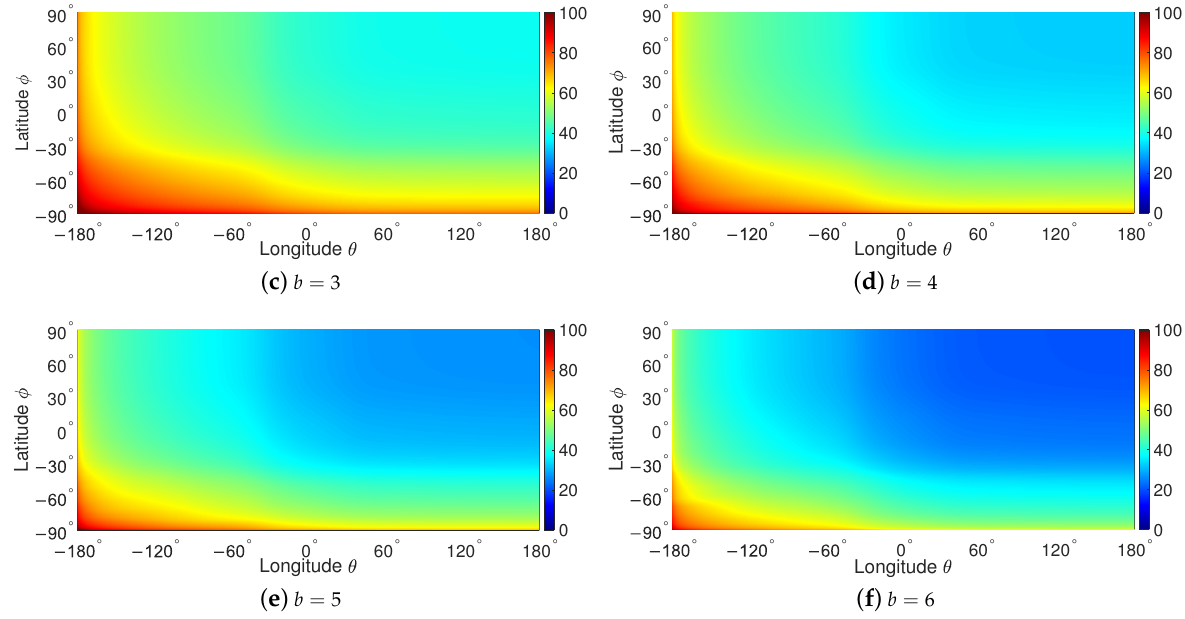
Figure 18. NCP-PSNR( φ , θ ) of viewing direction based LSB data hiding in the latitude and longitude of 360 ◦ cover video “Salon” for different number of bit